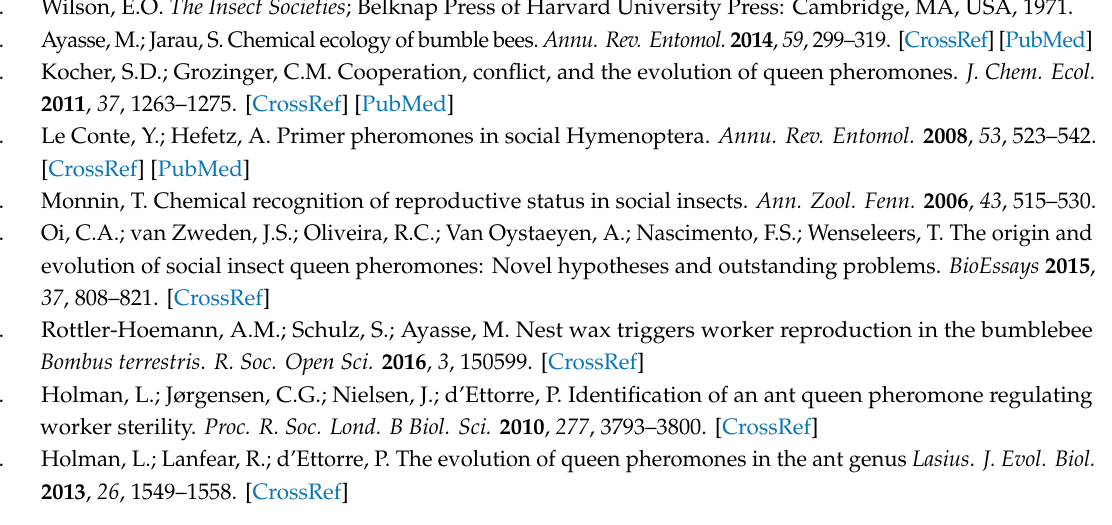
Figure S1: Comparison of relative amounts of (a) n-alkanes and macrocyclic lactones and (b) the n-alkene and isopentenyl ester which contributed more than 2.0% to the Bray–Curtis dissimilarities between nest foundresses and breeding queens, Figure S2: Comparison of relative amounts of (a) n-alkanes, (b) macrocyclic lactones and (c) n-alkenes and isopentenyl ester which contributed more than 2.0% to the Bray–Curtis dissimilarities between workers and breeding queens, Figure S3: Comparison of worker behavior interacting with another worker or a queen, Figure S4: Examples of coupled gas chromatographic and electroantennographic detection (GC-EAD) in cuticle surface extracts of L. pauxillum queens by using four di ff erent antennae of L. pauxillum workers and queens, Figure S5: Examples of coupled gas chromatographic and electroantennographic detection (GC-EAD) in cuticle surface extracts of L. malachurum queens by using four di ff erent antennae of L. malachurum workers and